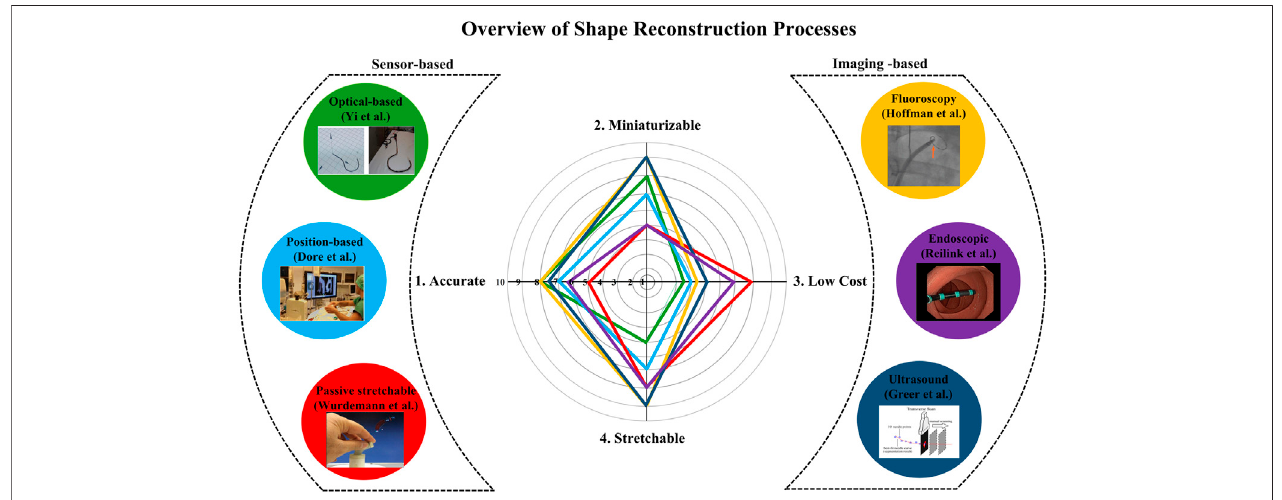
FIGURE 2 | Classi fi cation of sensor-based (Left) and imaging-based shape reconstruction process (Right) , and the comparison of each technique according to the properties (Middle) .